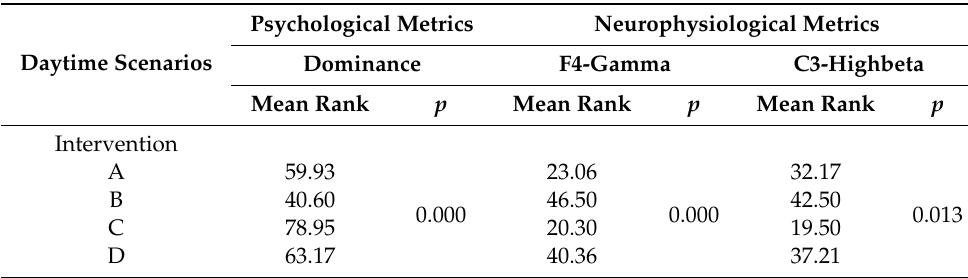
Kruskal-Wallis test for the di ff erences in the mean ranks of the psychological and neurophysiological metrics in daytime